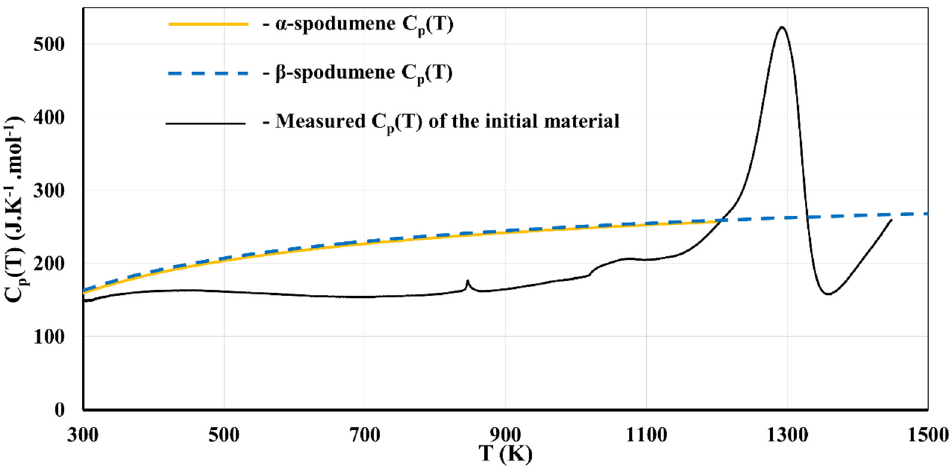
Figure 14. Derived C p (T) of the initial material compared to the calculated C p (T) of α -spodumene and β -spodumene.